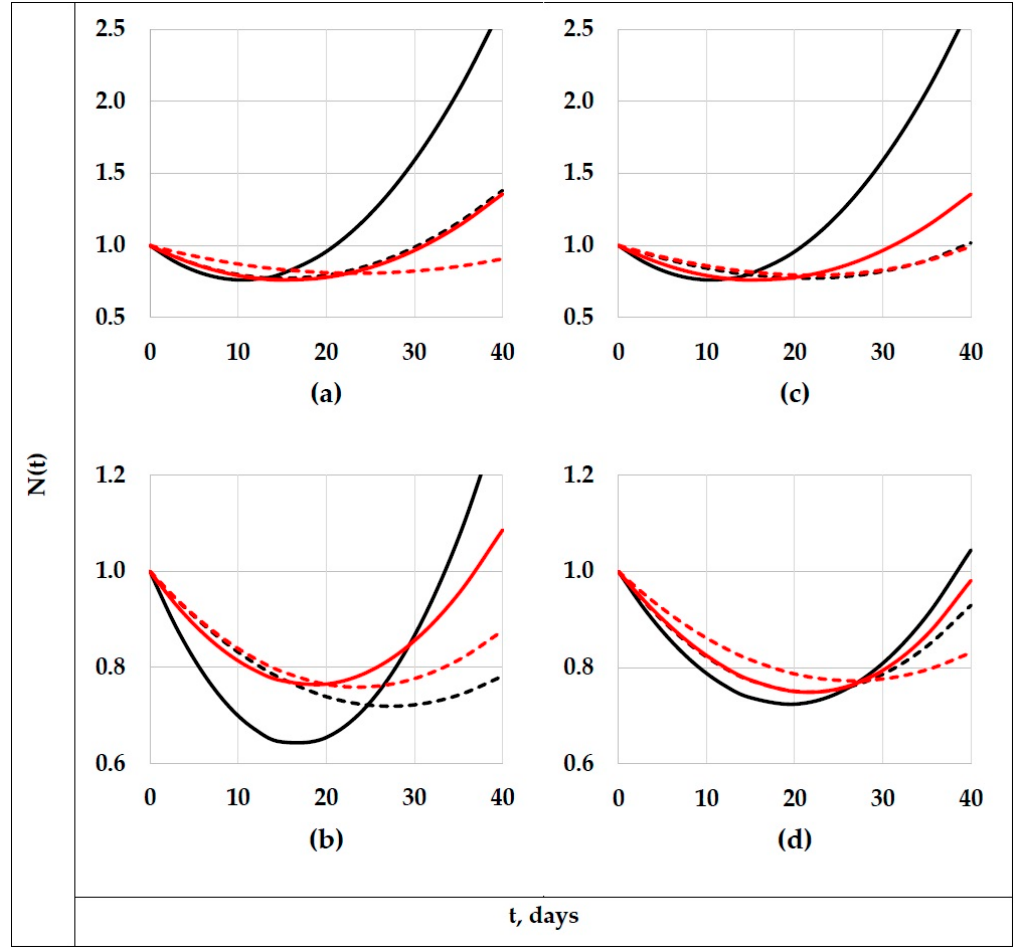
Figure 7. Graphic representation of Equation (4) (“master curves” N vs. t ), considering the respective parameters indicated in Table 5 for the formulations F1 (lines in black) and F2 (lines in red) degraded during the following periods: ( a ) P1 (continuous lines) and P3 (dotted-lines); ( b ) P not submerged (continuous lines) and P submerged (dotted-lines); ( c ) P1 (continuous lines) and P7 (dotted-lines); ( d ) P8 (continuous lines) and P4 (dotted-lines).